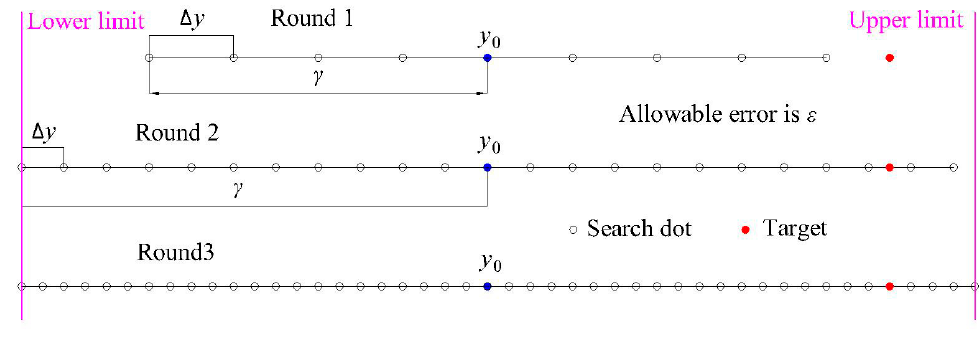
Figure 15. Theoretical limits of searching zones.